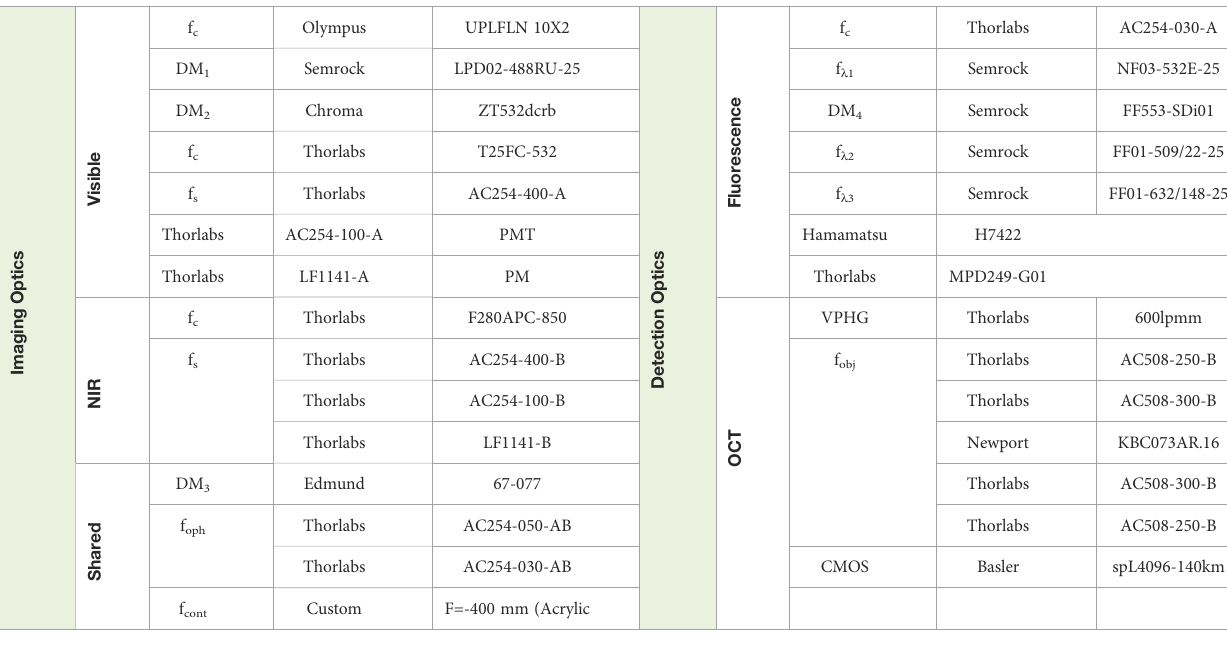
TABLE 1 Parts list for key system